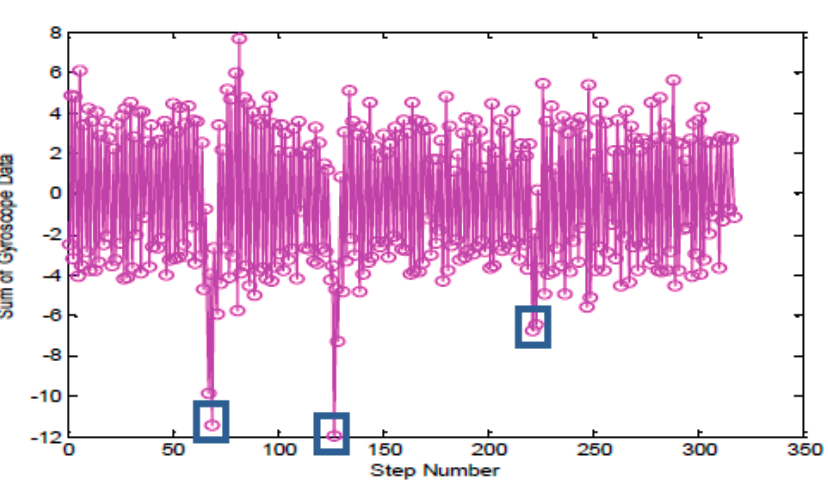
Figure 6. Walking trajectory.